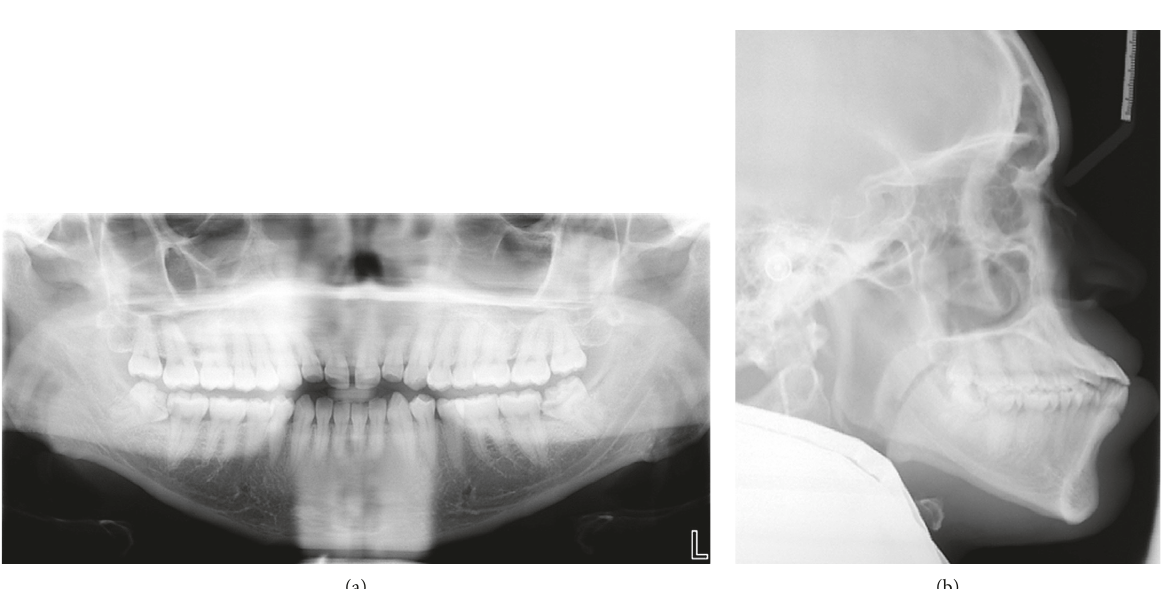
Figure 3: Pretreatment radiographs: (a) panoramic radiograph; (b) lateral